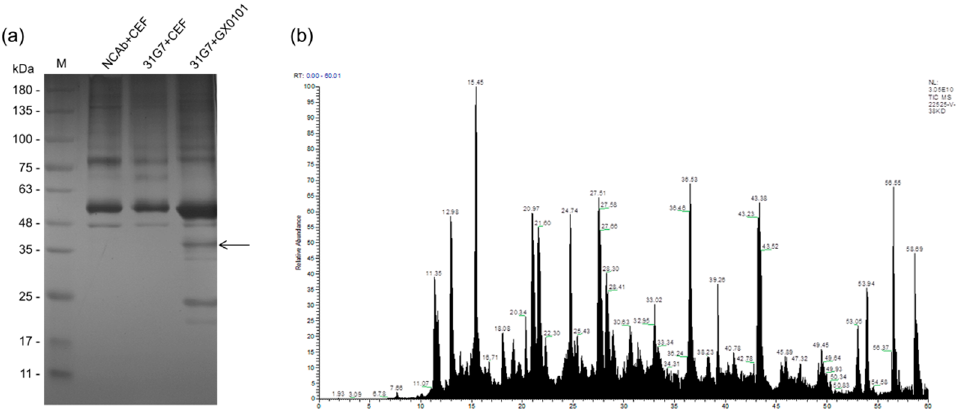
Figure 7. Immunoprecipitation and mass spectrometry analysis of the proteins recognized by the pp38 mAb 31G7: ( a ) Image of the immunoprecipitation and silver-stained SDS gel showing obvious protein bands captured by the pp38 mAb 31G7. The black arrow indicates the band of a target protein about 38 kD in size. ( b ) Image of total ion chromatography (TIC) for the 38 kD target band analyzed by LC–MS/MS.